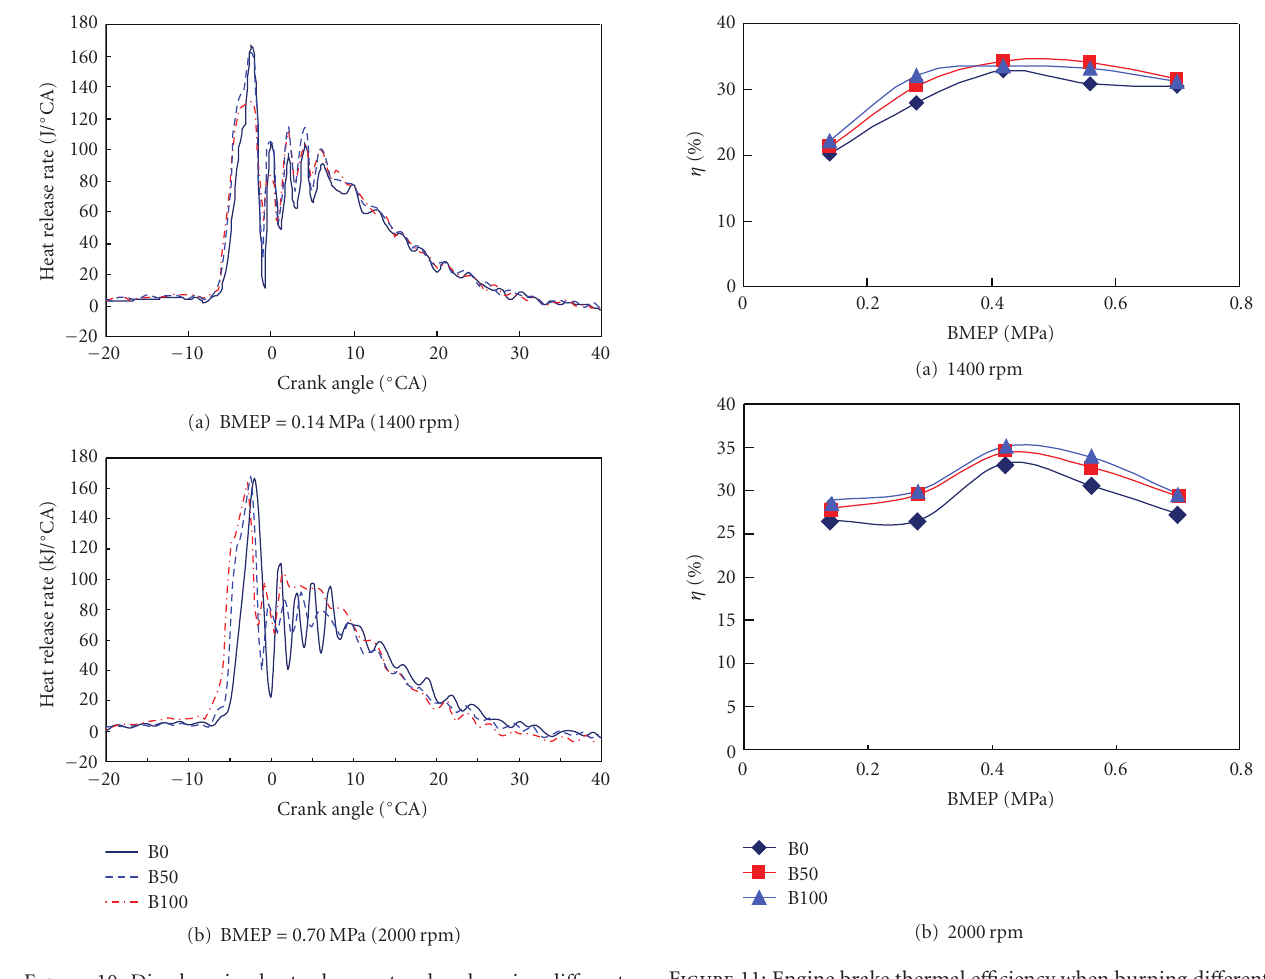
Figure 10: Diesel engine heat release rate when burning di ff erent fuels.